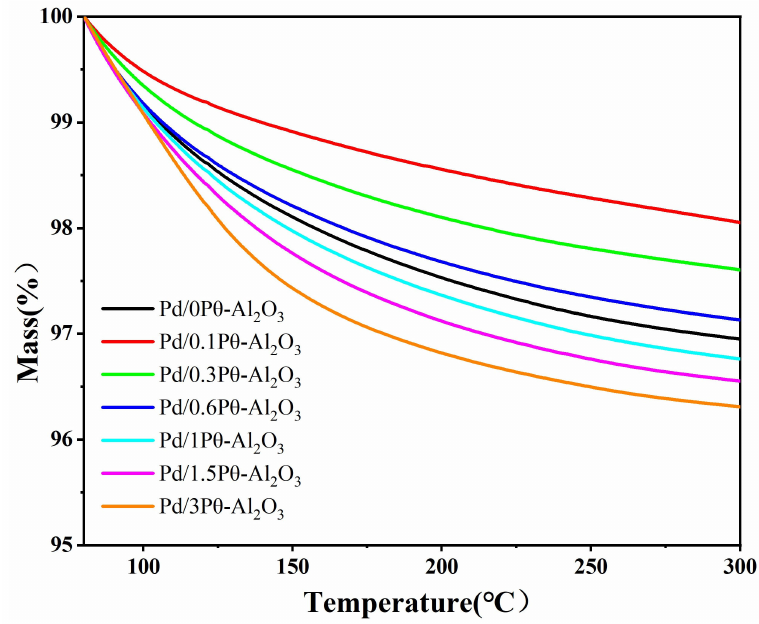
Figure 8. The weight loss curve of catalysts measured by TGA. The hydrophobicity of the Al 2 O 3 is determined by the hydroxyl content on its surface, so the NH 3 -TPD test, which measured the hydroxyl content of the samples, can further confirm the changes of hydrophobicity in the samples. Results are shown in Figure 9. The desorption curves of NH 3 of the samples had two peaks, which were similar to those of supports. Therefore, the peak 1 was attributed to the B acid produced by the hydroxyl groups on the surface of θ -Al 2 O 3 . The integral results of the curve of peak 1 is shown in Table S8. The law between the relative surface hydroxyl density and phosphorus content of the samples was consistent with that of hydrophobicity mentioned above, which once again proves that phosphates replaced the hydroxyl groups of θ -Al 2 O 3 to regulate hydrophobicity.